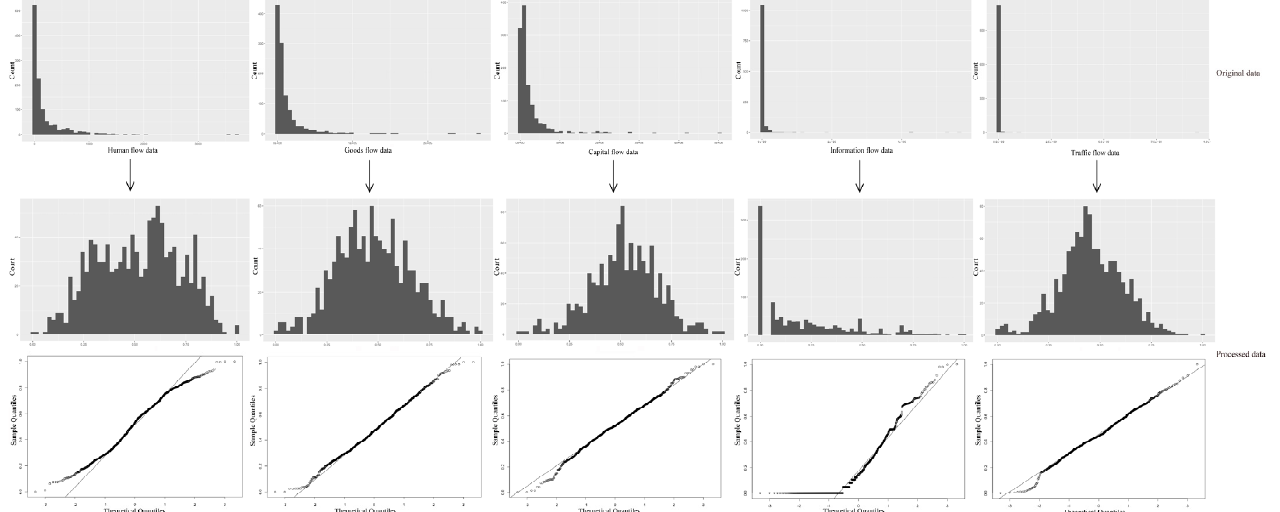
Figure 3. Frequency distribution diagram and Q-Q diagram of data before and after pre-processing.